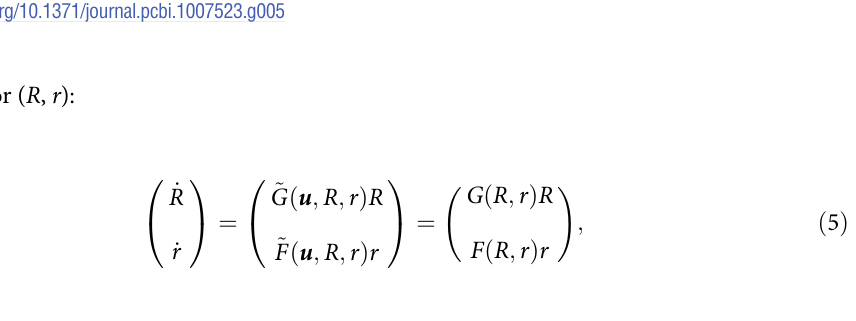
Fig 5. Existence of steady state. The blue curve describes the zero level-set of function G . The points ( R 1 , 0) and ( R 2 , R 2 ) correspond to the intersection of the zero level-set of function G with the lines r = 0 and r = R . The value of the function F in these points is negative. For r = 0 and r = R we are able to solve (1) explicitly. Moreover, we know that there exists at least one point ð ~ R ; ~ r Þ for which function F is positive. The latter is a consequence of the parameter choice. Thus there exists at least one point ( R � , r � ) such that: G ( R � , r � ) = 0, F ( R � , r � ) = 0 and in the neighborhood of this point for R > R � it holds F ( R , r � ) � 0 and for R < R � it holds F ( R , r � ) < 0. Further on, we will consider the stability of the steady state solution ( R � , r �